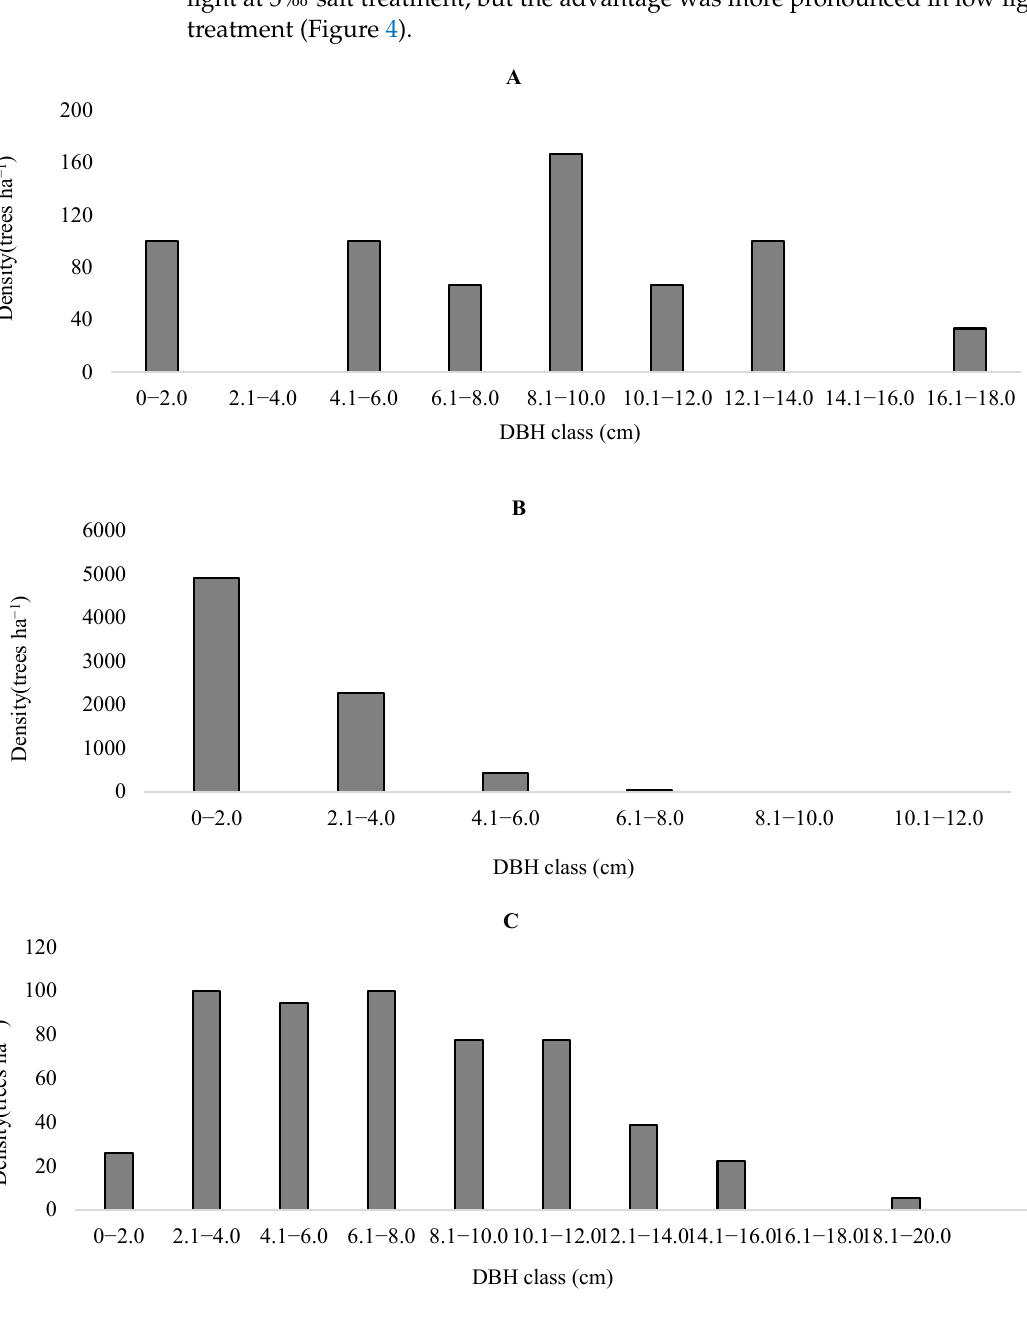
Figure 2. DBH class structure of Morus alba distributed in Jiufenchang ( A ), Shenxiangou ( B ), and reserve ( C ) R. pseudoacacia plantation. Table 2. Characteristics of stand structure of Morus alba in the different declining Robinia pseudoacacia plantation.